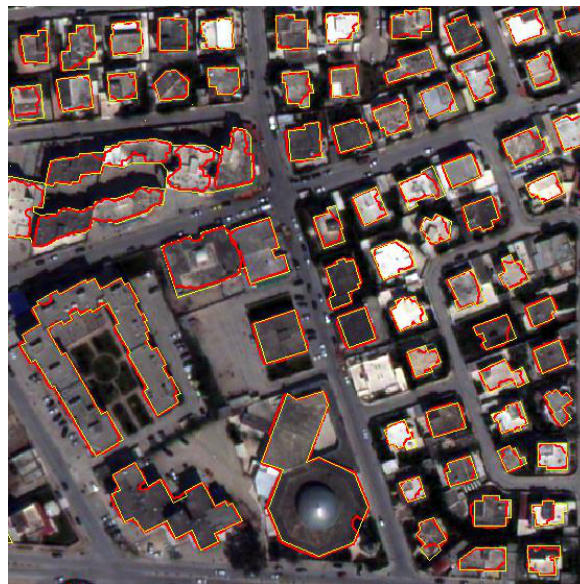
Figure 7. Overlaid reference polygons (yellow) and final results of map updating (red) over orthorectified worldview-2 satellite image